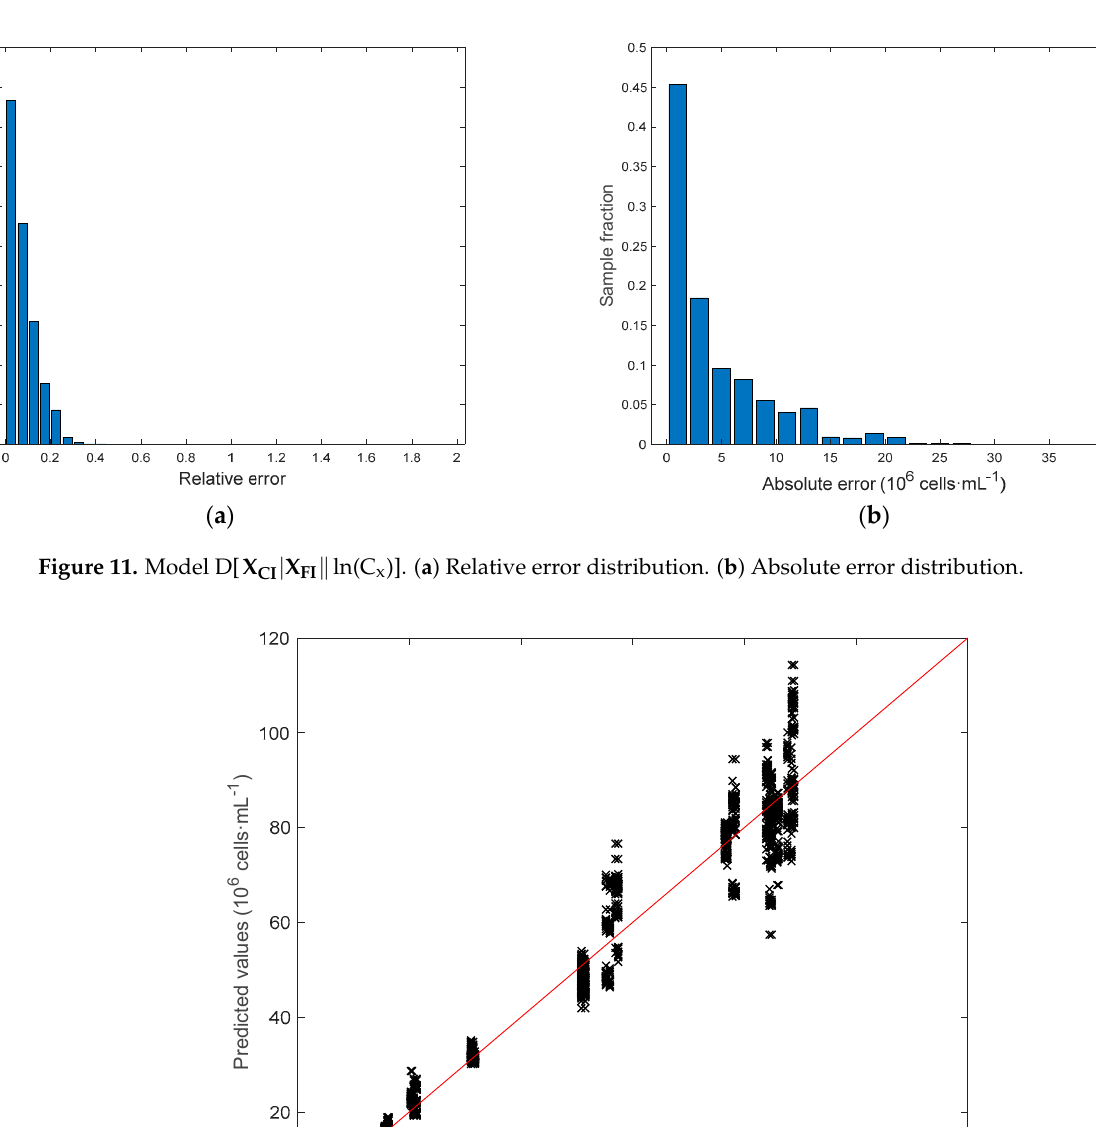
Figure 12. Parity plot for model D[ 𝐗